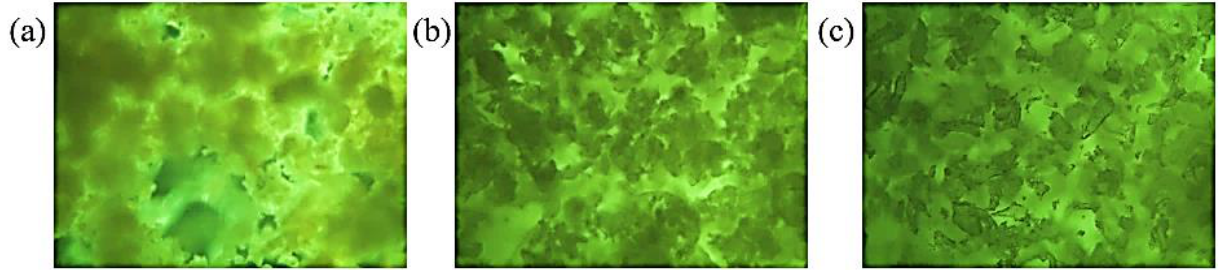
Figure 8. Polarized optical microscopy (POM) microscopes of CS ( a ), CSC ( b ), CSS ( c ).